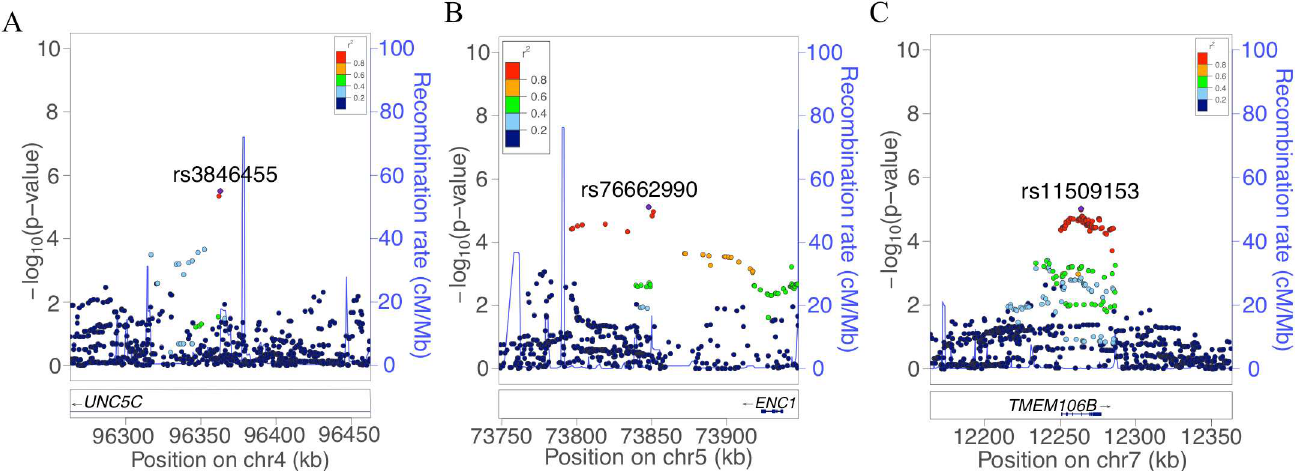
Fig 2. Regional genetic association plots for UNC5C , ENC1 , and TMEM106B regions. In these regionalplots, we present the associationresults for all SNPs (dots) within each regionof interest. In each region, the lead SNP is colored in purple, and other SNPs are colored basedon their extent of linkagedisequilibrium with the lead SNP, followingthe color key includedat the top right of each panel.The x -axis denotes the physicalposition of the SNP, and the y -axis reports − log( p- value) for each SNP. The blue line denotesthe recombination rate in this region in EUR participants from the 1000 Genomes Project. The locationof the gene is presented at the bottom of the figure. (A) UNC5C regionwhere rs3836455(hg19 chr4:96363012)is the lead SNP associatedwith residualcognition. (B) ENC1 region where rs76662990 (hg19 chr5:73847916)is the leadSNP. (C) TMEM106B regionwhere rs11509153(hg19 chr7:12263800)is the lead SNP. Regionalgeneticassociationplots were plotted with